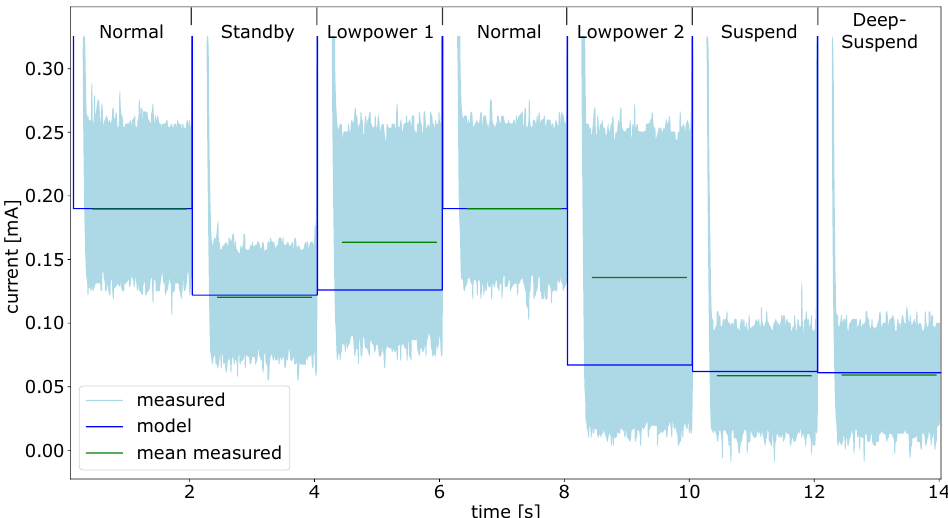
Figure 12. Accelerometer power modes model data and measured current